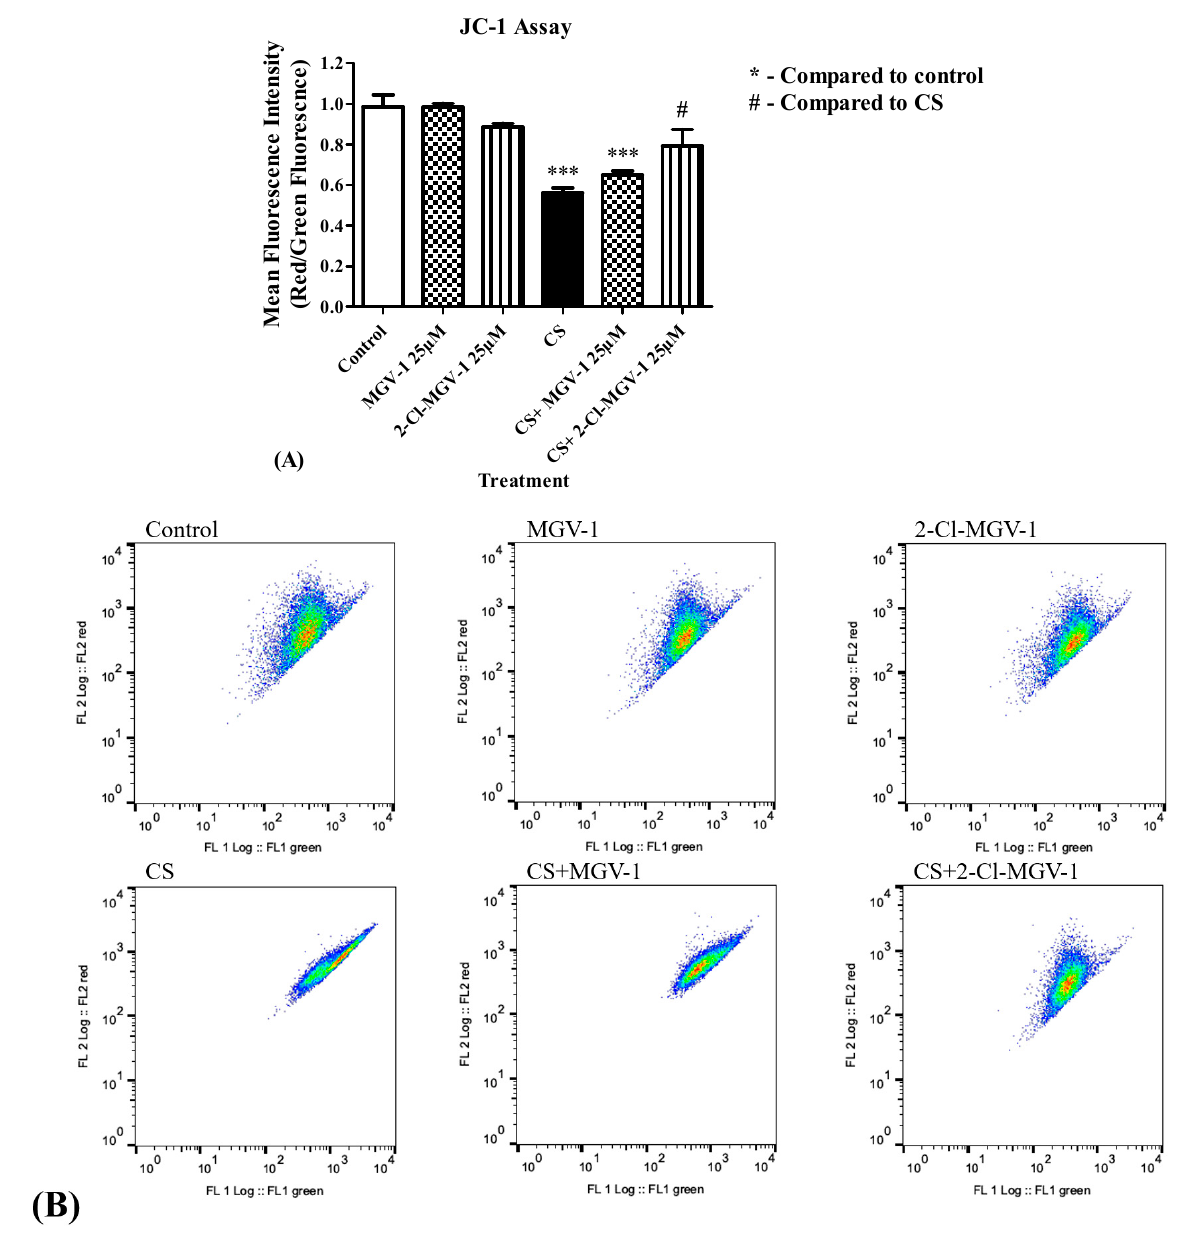
Figure 8. The impact of TSPO ligands on CS-induced mitochondrial membrane potential depolarization in H1299 lung cancer cells. ( A ) FACS was used to quantify the levels mitochondrial membrane potential depolarization following exposure to 60 min of CS. Significant ΔΨ m depolarization was seen after exposure to CS and protection by pretreatment with 2-Cl-MGV-1 to control range. ( B ) The results are expressed by the mitochondrial membrane depolarization in the different cellular population in each experimental group. The control, MGV-1 and 2-Cl-MGV-1 groups were exposed to fresh air only. Results are represented as mean ± SEM ( n = 5 in each group). # p < 0.05 vs. CS and *** p < 0.001 vs. control. CS = cigarette smoke.